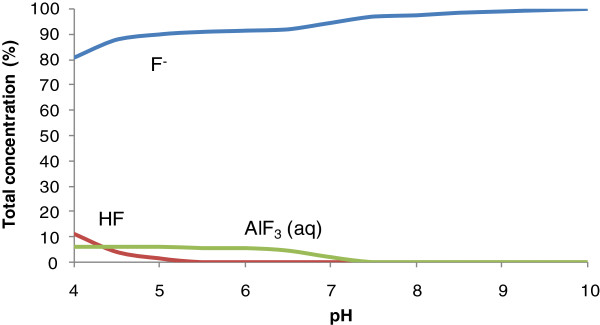
Calculated fluoride speciation as a function of pH in the presence of aluminium ([Al] = 10.4 μM, [F] = 379 μM, Table6).